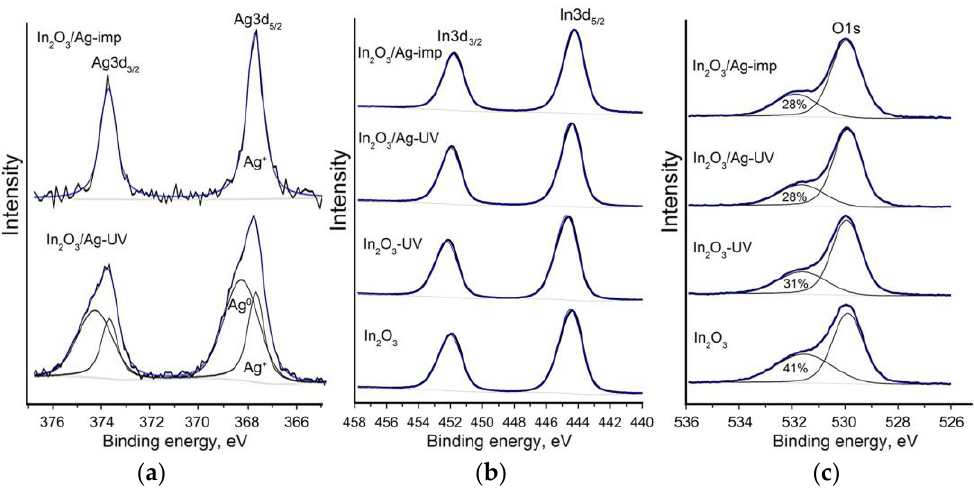
Figure 6. ( a ) EDX map of element distribution in In 2 O 3 /Ag-UV nanocomposite. ( b ) EDX map of corresponding Ag L α1 signal.